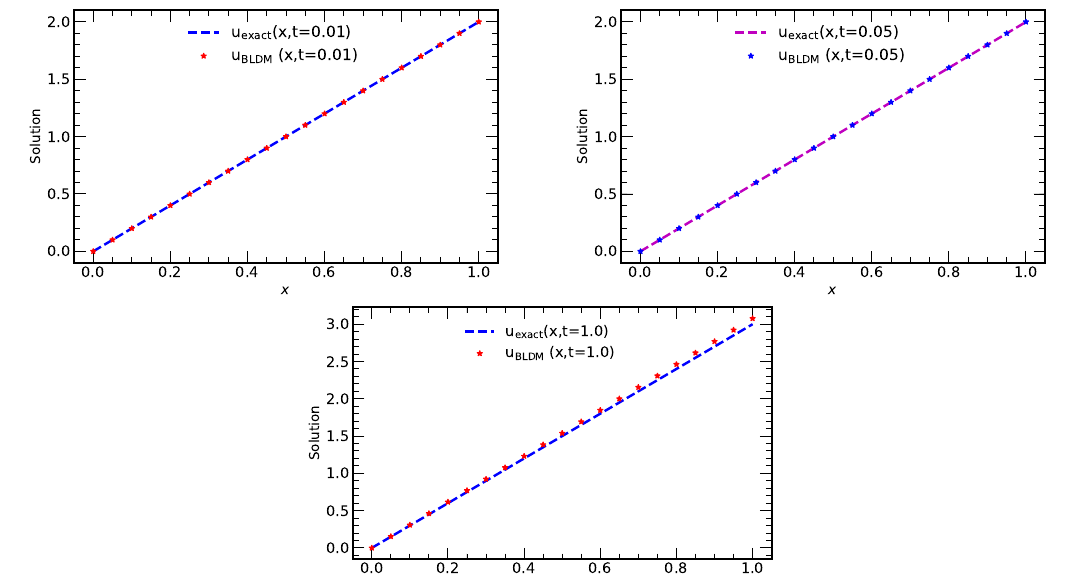
Figure 15. Plots of exact solution and solution using BALDM at different t -values, t = 0.01,0.05,1.0 (for numerical experiment 3).